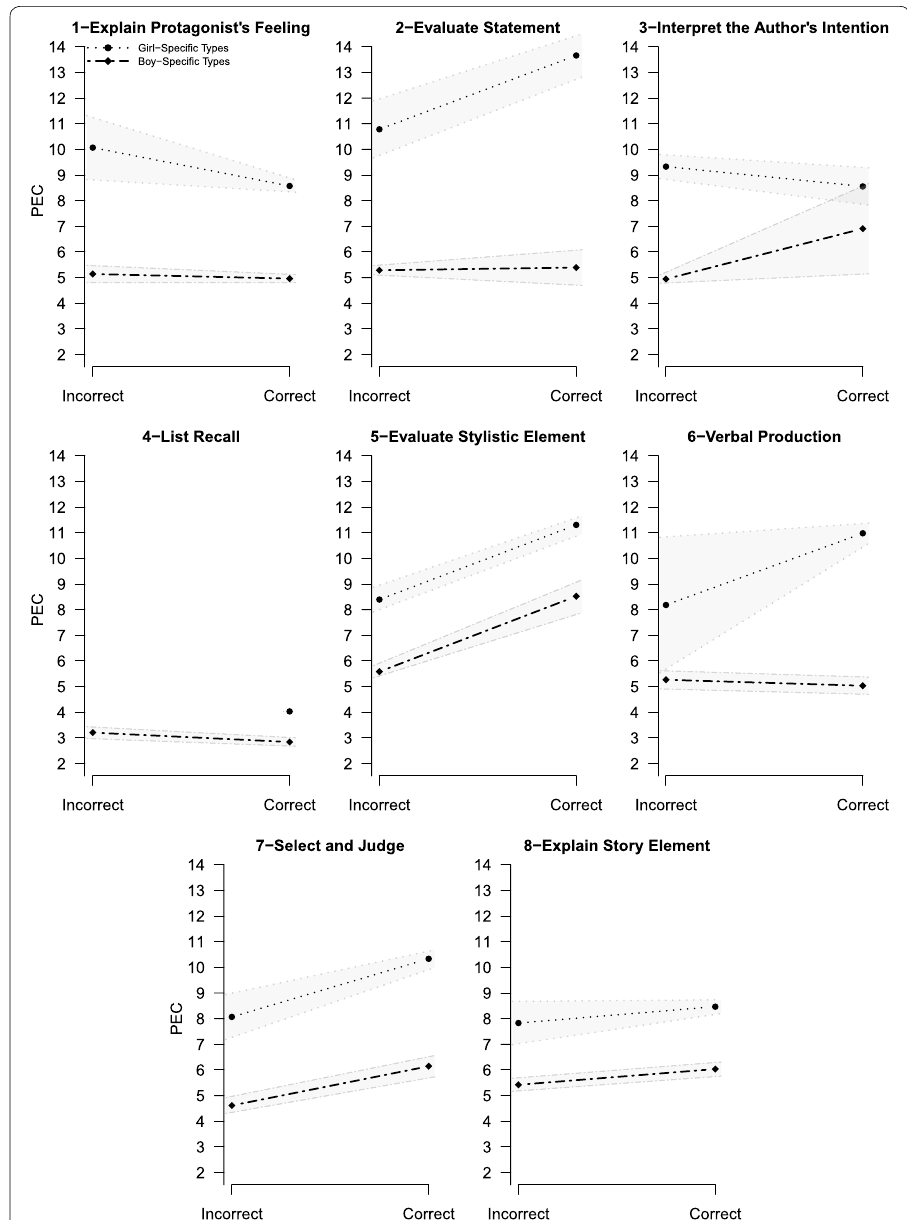
Fig. 2 PEC by gender type and response correctness (with 95% confidence